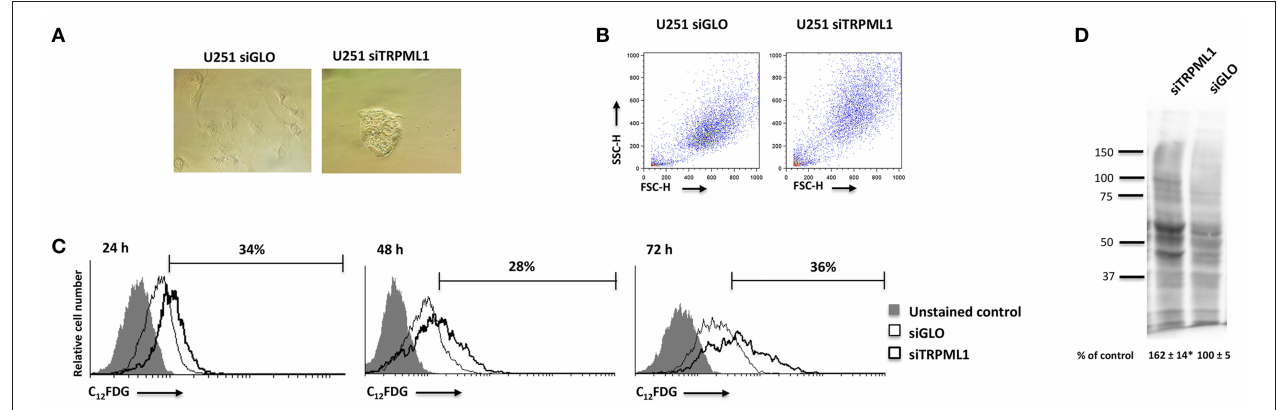
FIGURE 5 | Silencing of transient receptor potential mucolipin 1 (TRPML1) induces senescence in U251 cells. (A) Representative image of siGLO and siTRPML1 U251 cells 48h after silencing. Magnification × 10. (B) Dot plots show forward scatter (FSC) and side scatter (SSC) for siGLO and siTRPML1 U251. (C) Representative flow cytometric profiles of siGLO and siTRPML1 U251 cells stained with C 12 FDG, a fluorogenic substrate from SA- β -galactosidase before the analysis. Data represent the percentage of positive cells. Gray curve represents unstained cells. (D) Carbonyl groups generated by oxidative stress were subjected to DNPH derivatization, and increases in oxidatively modified proteins were detected with an antibody against DNP after size fractionation followed by Western blotting. Quantification of total protein carbonylation was performed from three independent experiments ± SEM. Image is representative of three independent experiments. * p < 0.01 vs.